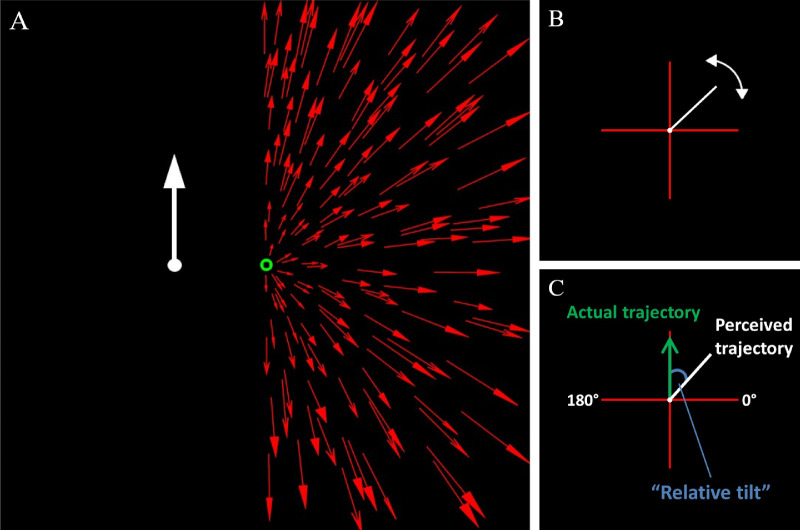
(A) Schematic of one example stimulus used in Experiment 2 with flow in the right hemifield and probe in the left hemifield. The central arrow represents the 90° condition in which the probe moved vertically upwards. (B) Schematic of the on-screen axis and paddle. Participants rotated the white line CW or ACW (between 0° & 180°) to represent the perceived trajectory of the probe. (C) Illustration of the relative tilt as the angular difference between the perceived and actual trajectories. Adapted from Warren & Rushton, 2009a.